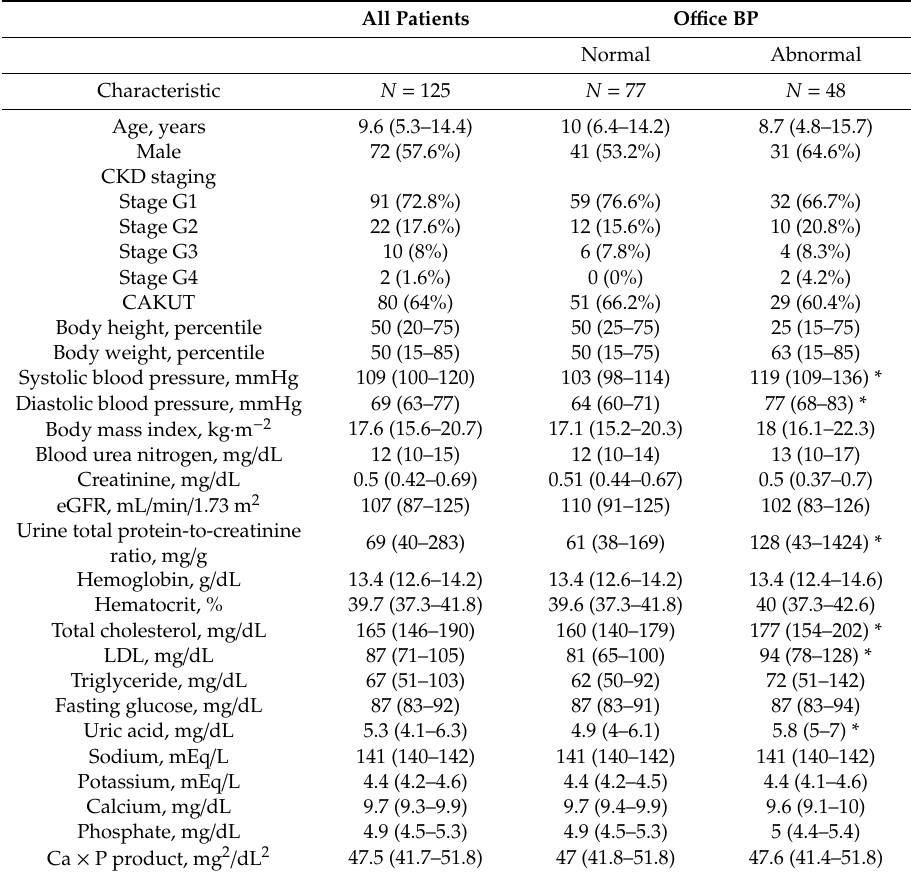
Table 1. Patient characteristics in children and adolescents with CKD.